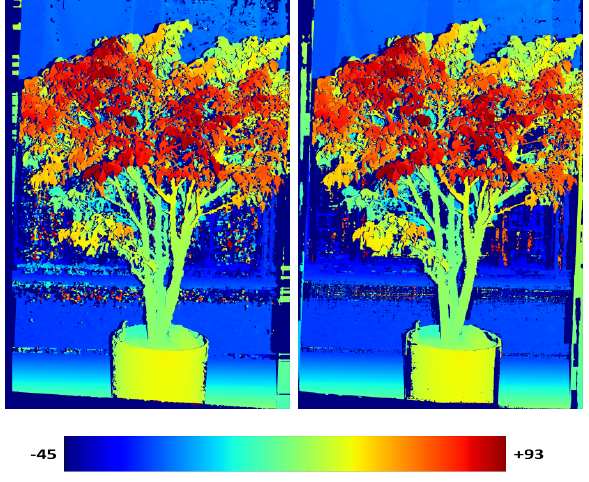
Figure 5. The disparity maps generated using Census (left) and MC-CNN (right) as matching cost